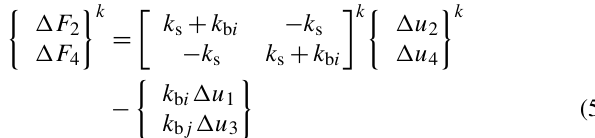
N m · (cid:49)u m , where N m is a shape c m